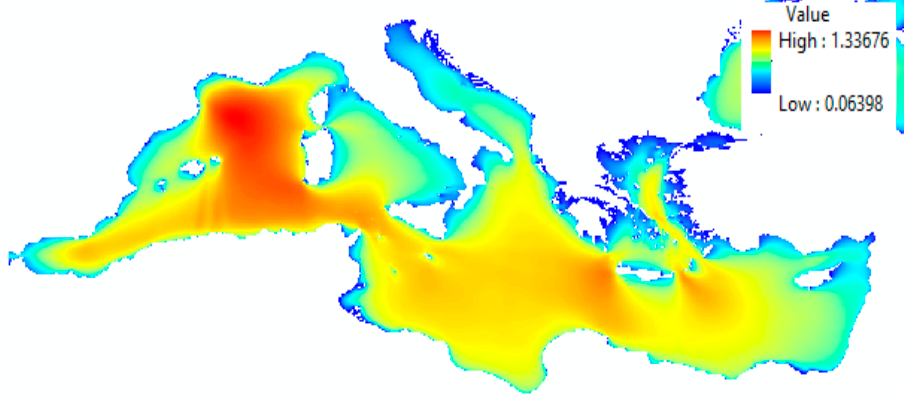
Figure 3. Mean wind power (MWP) (kW) with 10 m height in the Mediterranean Sea for the years from 2010 to 2017.